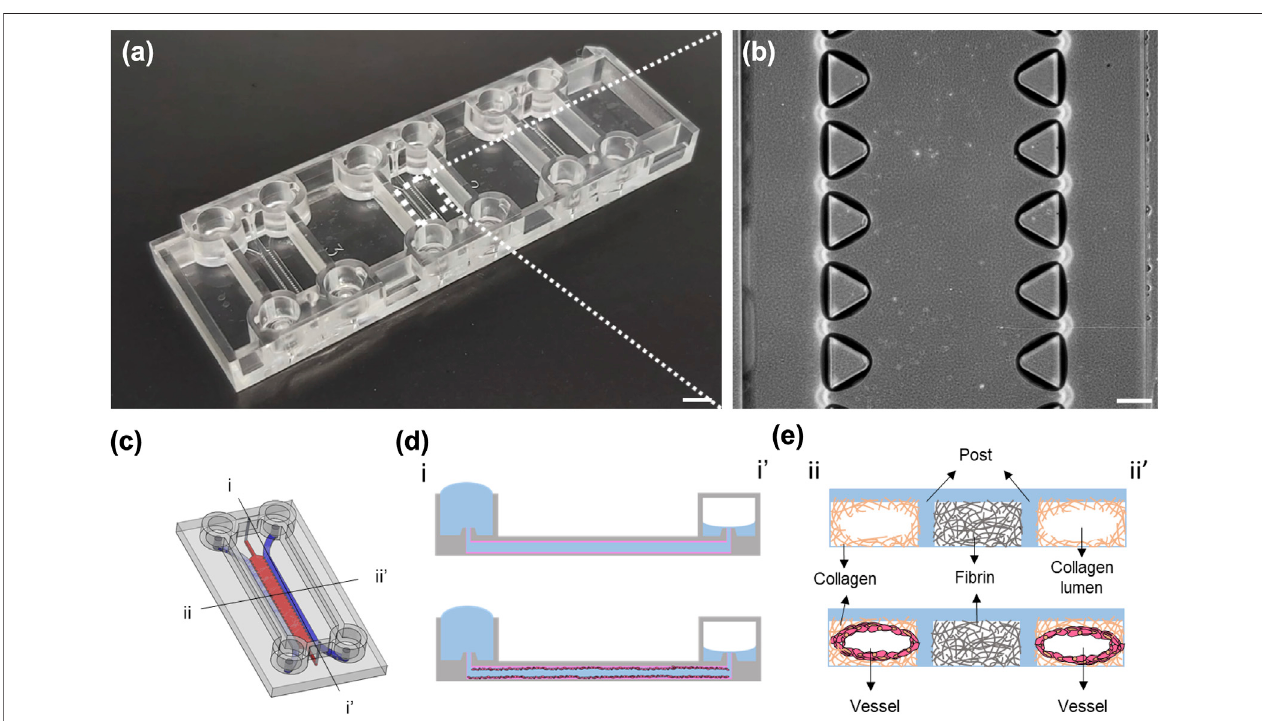
FIGURE1| ImagesoftheAIMchipandtheschematicillustrationoftheviscous fi ngering(VF)processes. (A) PhotographofanAIMchip.Eachchipcomprisesthree independentexperimentalsitesforthreeexperiments.Scalebar:5 mm. (B) Phasecontrastimageofthethreechannelsandthetrapezoidalmicropillarsthataredesigned to containunpolymerized hydrogel within thehydrogel channelat each experimental site. Scale bar: 200 µm. (C) Schematic illustration oftheexperimental site inan AIM chip,with twomedia channels (blue) and onegel channel (red). (D) The cross-sectional view(i-i ′ ) ofthe media channel depicting the formationofalumen within the collagen using the VF technique and subsequent seeding of HUVECs in the lumen. (E) The cross-sectional view (ii-ii ′ ) of the lumens within the collagen and